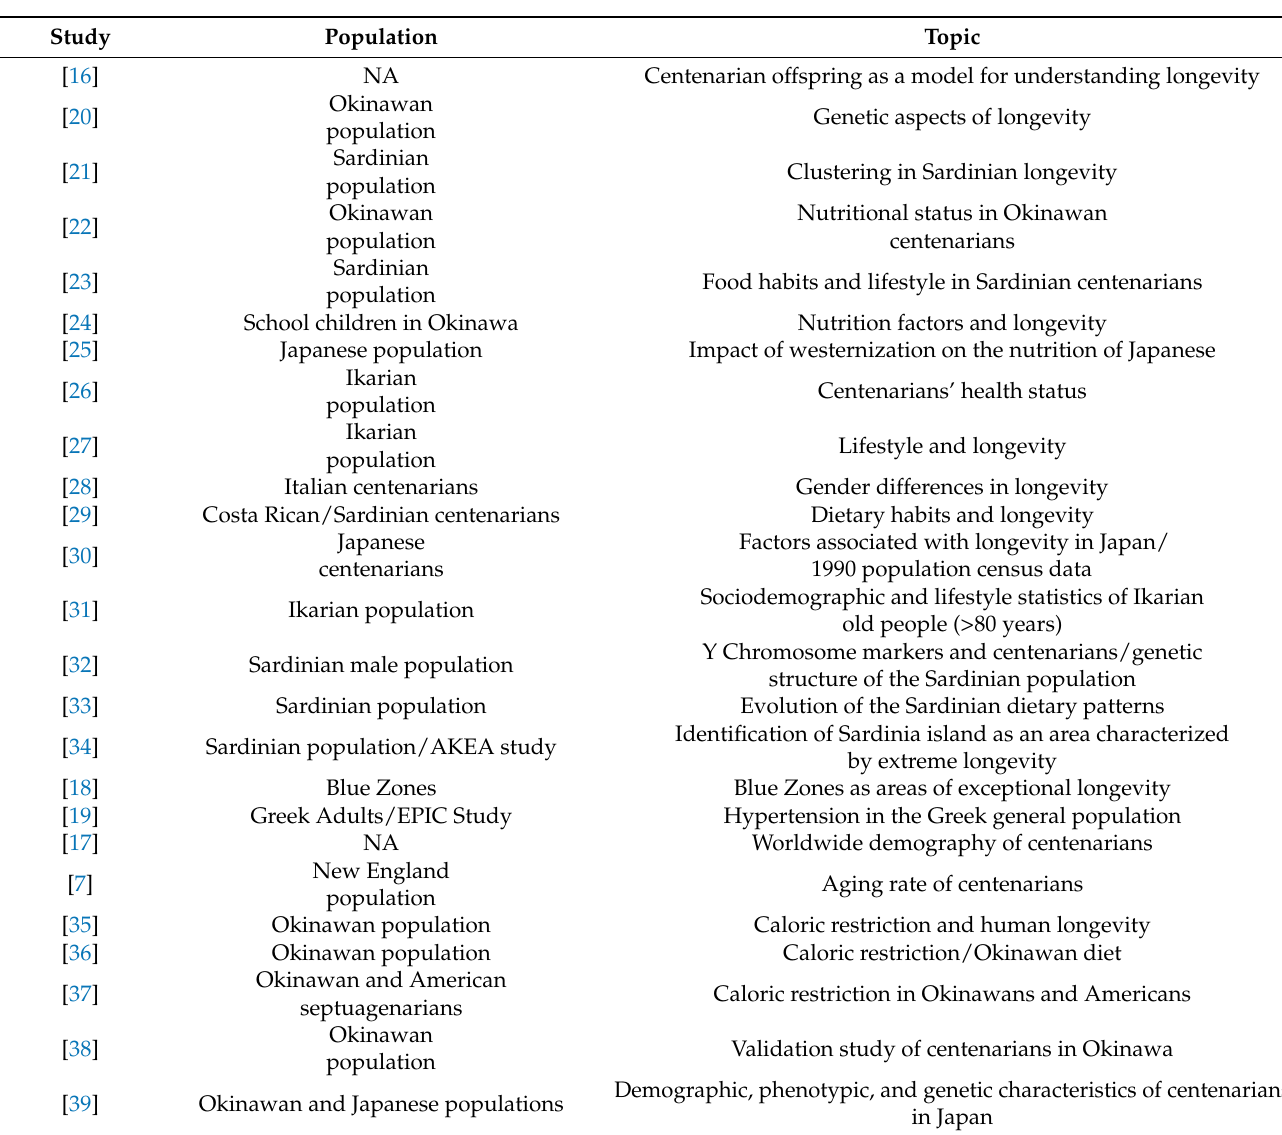
Table 1. Most relevant studies on human